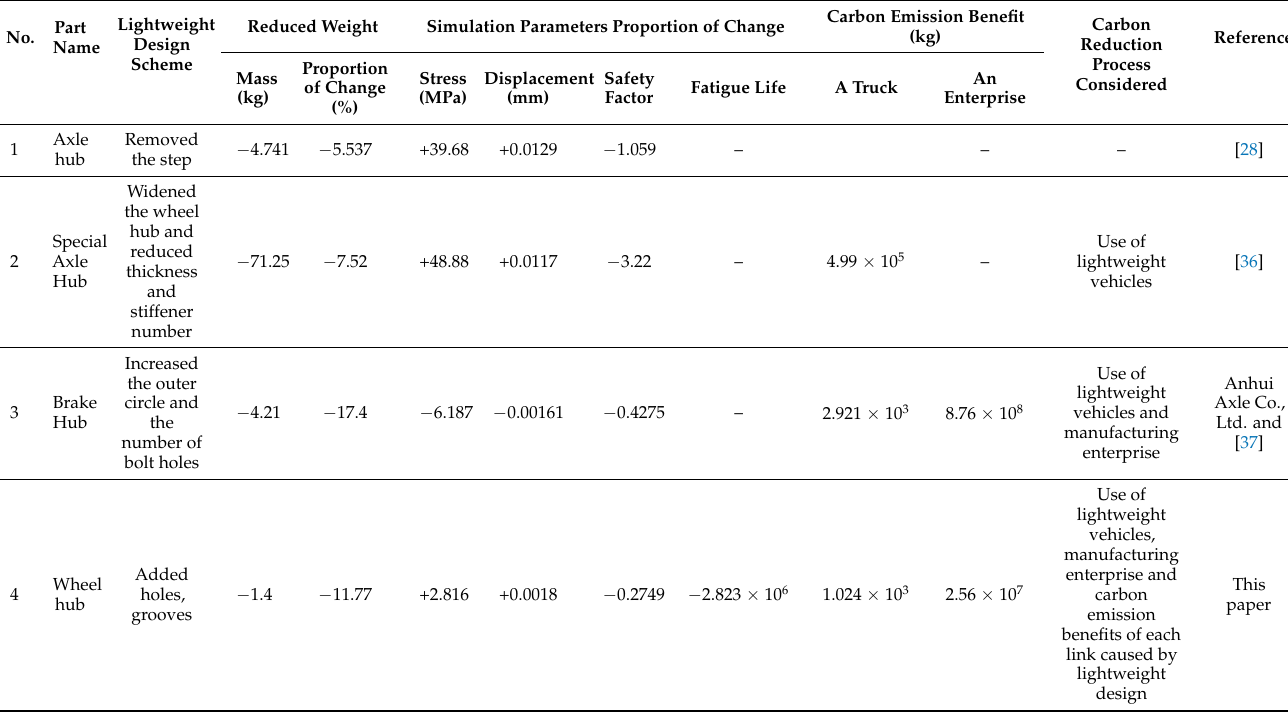
Table 5. The application of this method to the automobile